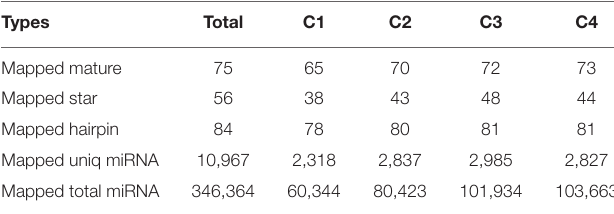
TABLE 4 | Number of combined difference (DIFF), upregulated (UP), and downregulated (DOWN) miRNAs in each group.